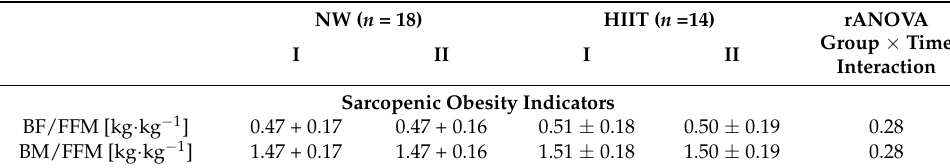
Table 1. Characteristic of